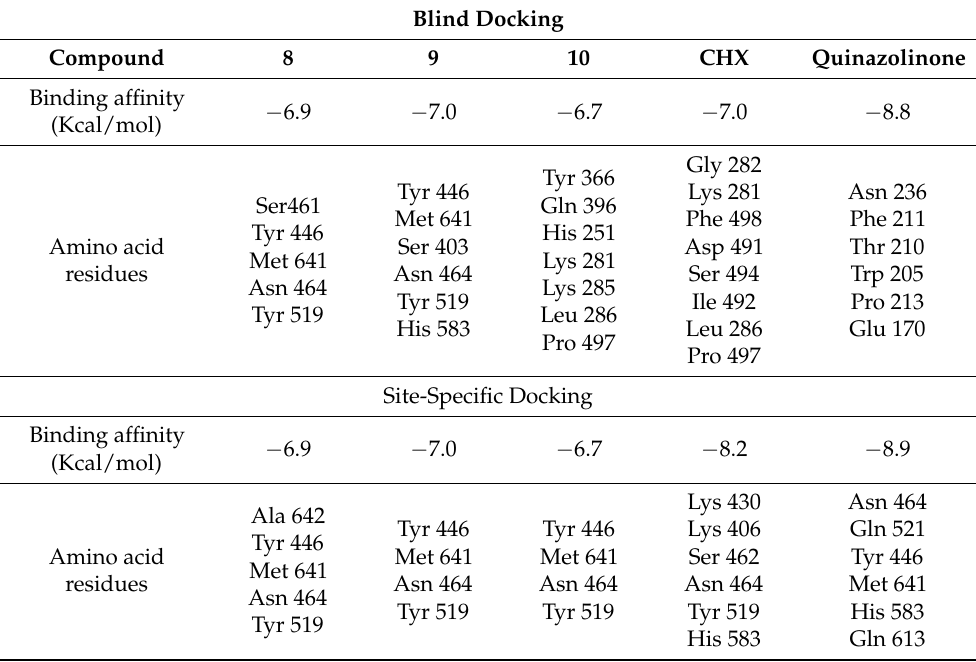
Table 3. Concentrations of compounds 8 , 9 , and 10 used (0 × MIC, 1 × MIC, 2 × MIC and 4 × MIC) for the time-kill